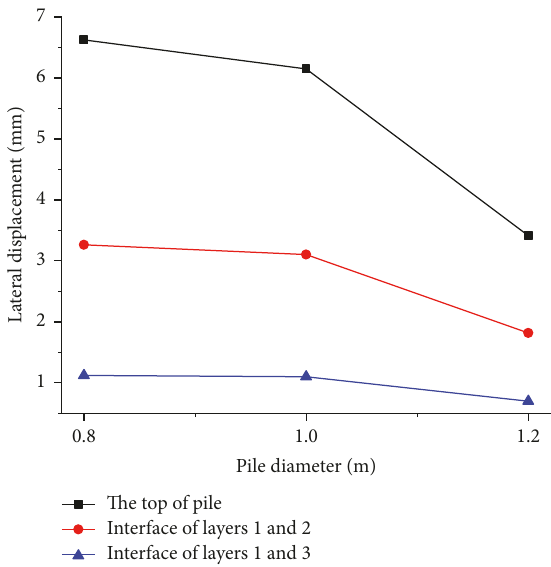
Figure 9: Relationship between lateral displacement of pile and pile diameters.